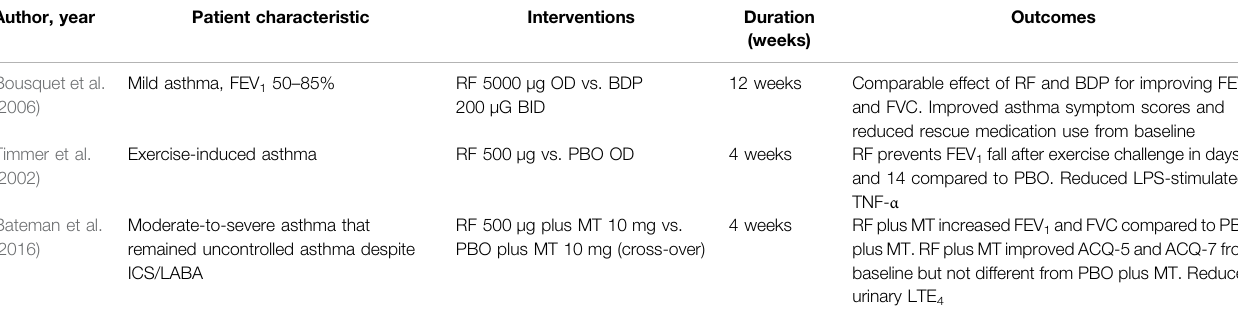
TABLE 3 | Clinical ef fi cacy of ro fl umilast on asthma patients in clinical trials. Author, year